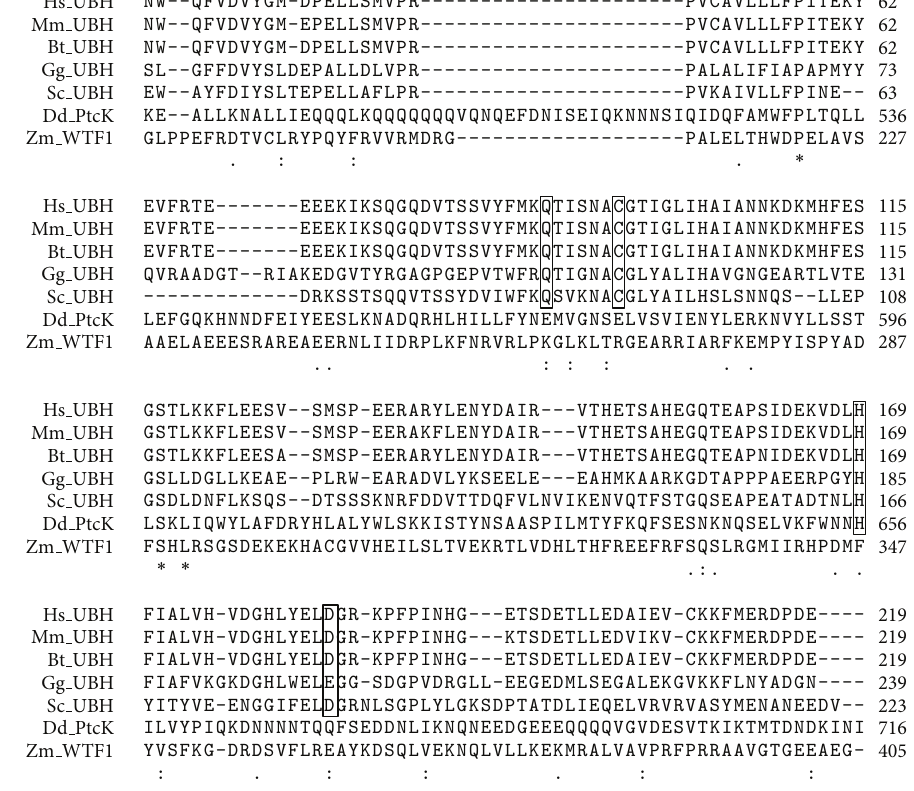
Figure 2: Amino acid sequence alignment of PtcK from D. discoideum (Dd) with ubiquitin hydrolases (UBHs) from other organisms. Sequences used in the alignment include UBHs from Homo sapiens (Hs, accession number NP 005993), Mus musculus (Mm, accession number AAF64193), Bos Taurus (Bt, accession number NP 001035631), Glomerella graminicola (Gg, accession number EFQ25707), Saccharomyces cerevisiae (Sc, accession number EDN63415), and WTF1, a PORR-containing protein from Zea mays (Zm, accession number ACI96105). Only the relevant portion of the alignment is shown. Boxed residues indicate conserved amino acids required for ubiquitin hydrolase activity while identical ( ∗ ), conserved (:), and semiconserved (.) amino acids are also